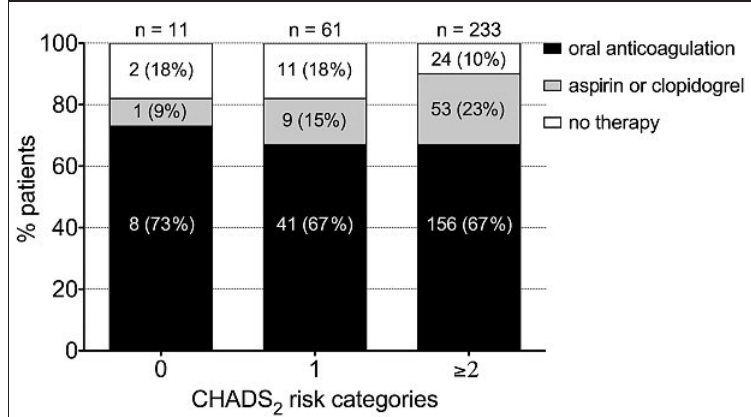
Antithrombotic treatment in different stroke risk categories on admission. Although guidelines recommend thromboembolic prevention with aspirin in low risk patients (CHADS 2 = 0) the majority were treated by oral anticoagulation, whereas one third of eligible patients did not receive recommended OAC.The rate of OAC prescription was similar in the three risk categories (p =